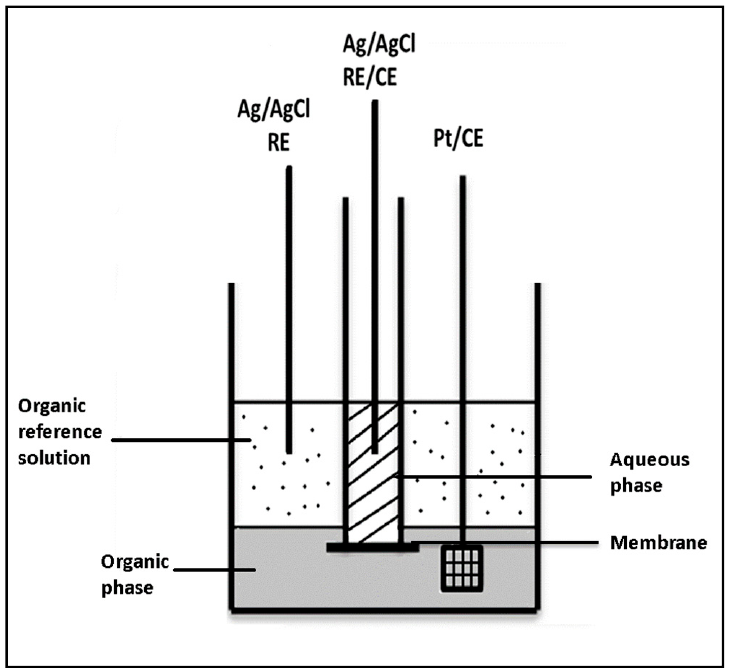
Figure 2. Schematic diagram of the three-electrode electrochemical cell used to support micro-ITIES arrays.